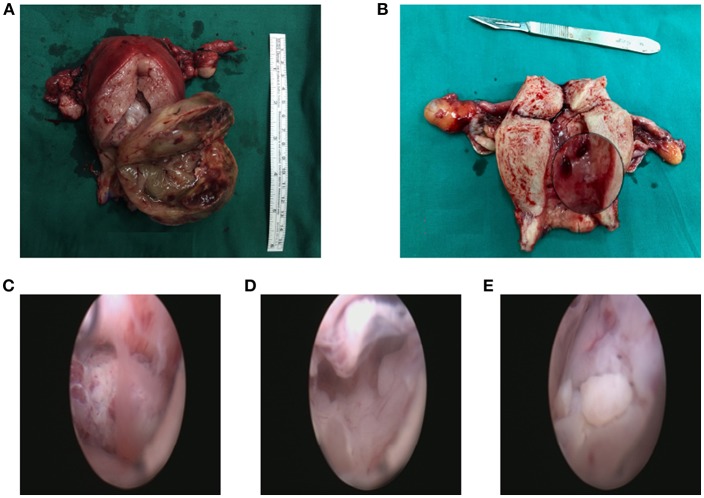
The tumor with a stalk to the uterine (A). The residual stalk root after tumor resection (B). Extensive lesions without a stalk (C–E).